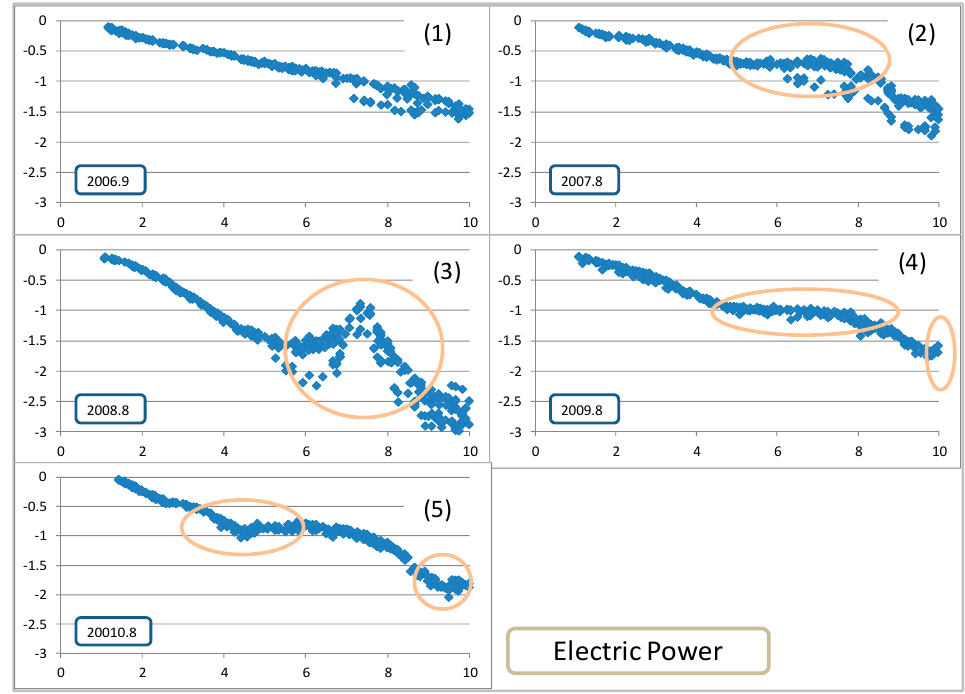
Figure 7. Yearly changes of CRiPS-plots of CBs in the electric power industry (11 companies) for August 2006 to August 2010.